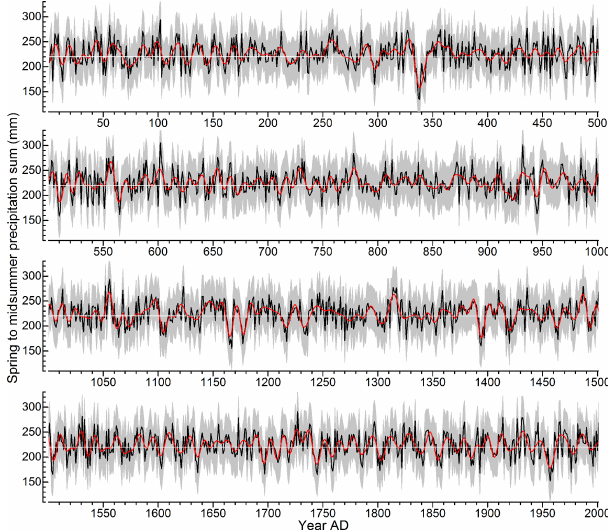
Figure 4. Reconstruction of spring to midsummer season precipi- tation variability for the MR. Reconstruction of precipitation sum from 26 February to 6 July (black) and 10-year low-pass-filtered reconstruction (red) during AD1–2000. RMSE (light grey shaded); mean precipitation sum during the AD1901–2000 reference period (thin white line).